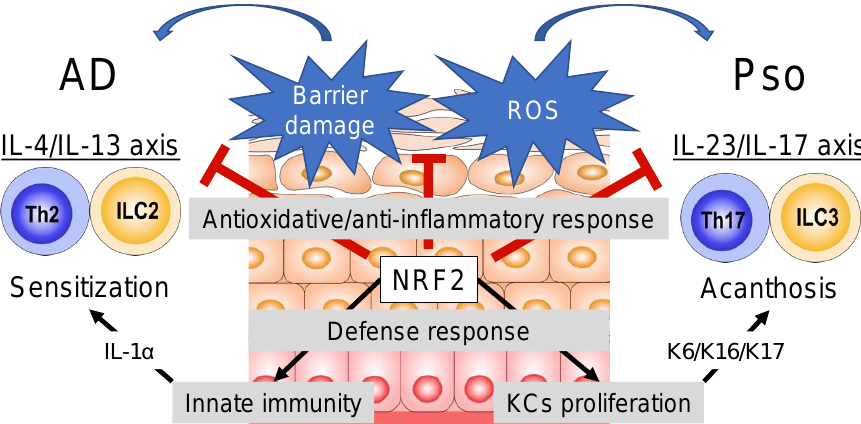
Figure 1. The KEAP1-NRF2 system in the pathophysiology of atopic dermatitis and psoriasis.